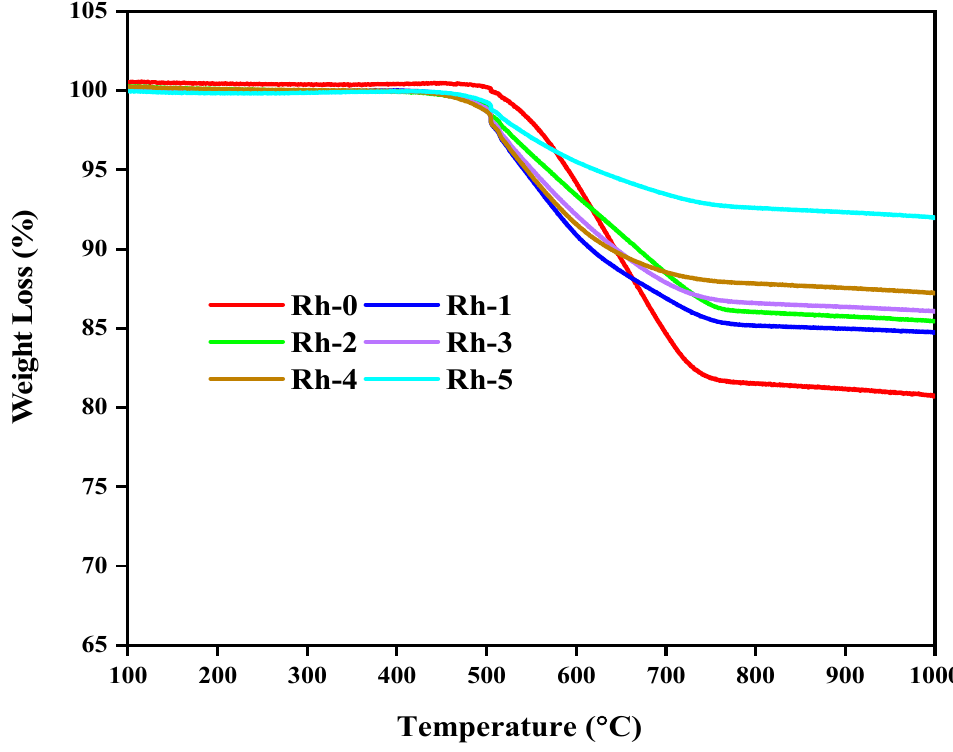
Figure 8. TGA profiles for the Rh-x (x = 0, 1, 2, 3, 4, 5 wt.%) catalysts after TOS of 420 minutes in DRM, at 800 ° C and 1 atm.